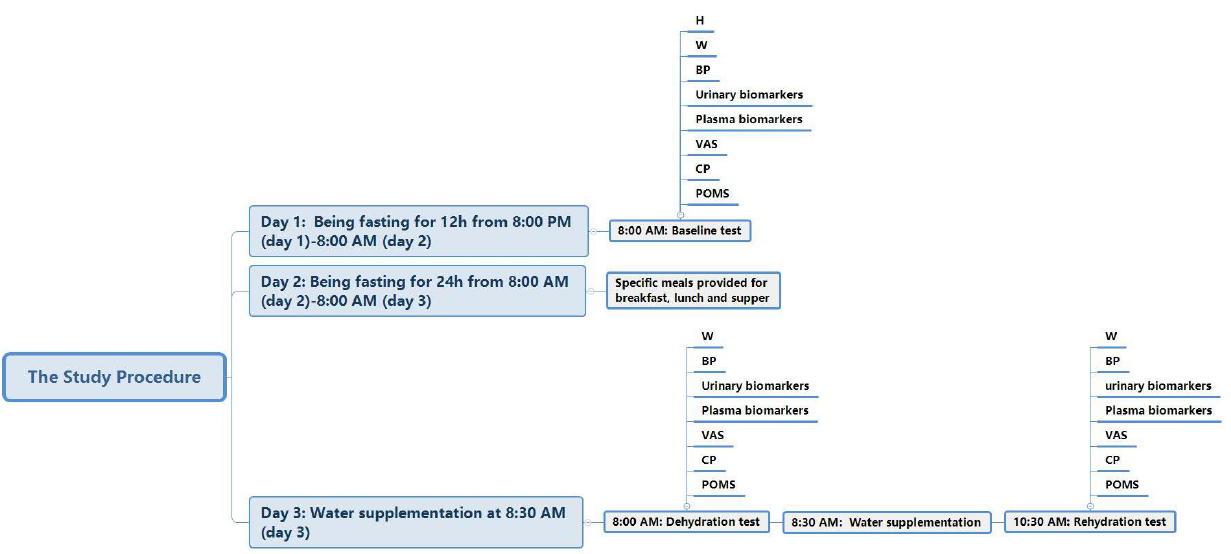
Figure 2. The study procedure (Note: H (height); W (weight); BP (blood pressure); VAS (visual analogue scales); CP (cog- nitive performance); POMS (profile of mood states).